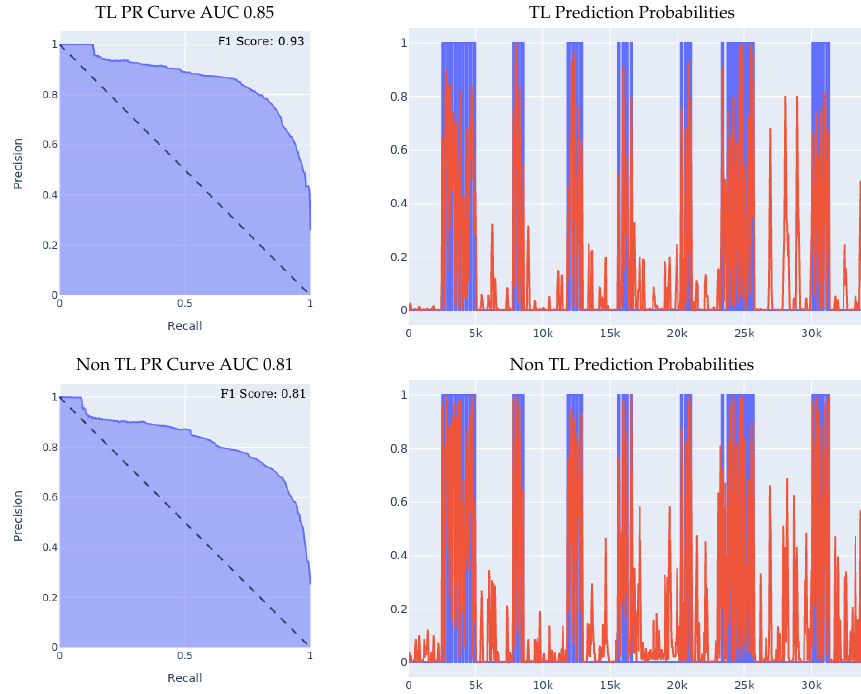
Figure 7. 70/30 Train/Test data split experiment for MSBAND to meta-sensor. For prediction probabilities, x axis is the time, y axis is the prediction threshold, blue data is the real labels, and red data is the prediction probabilities.